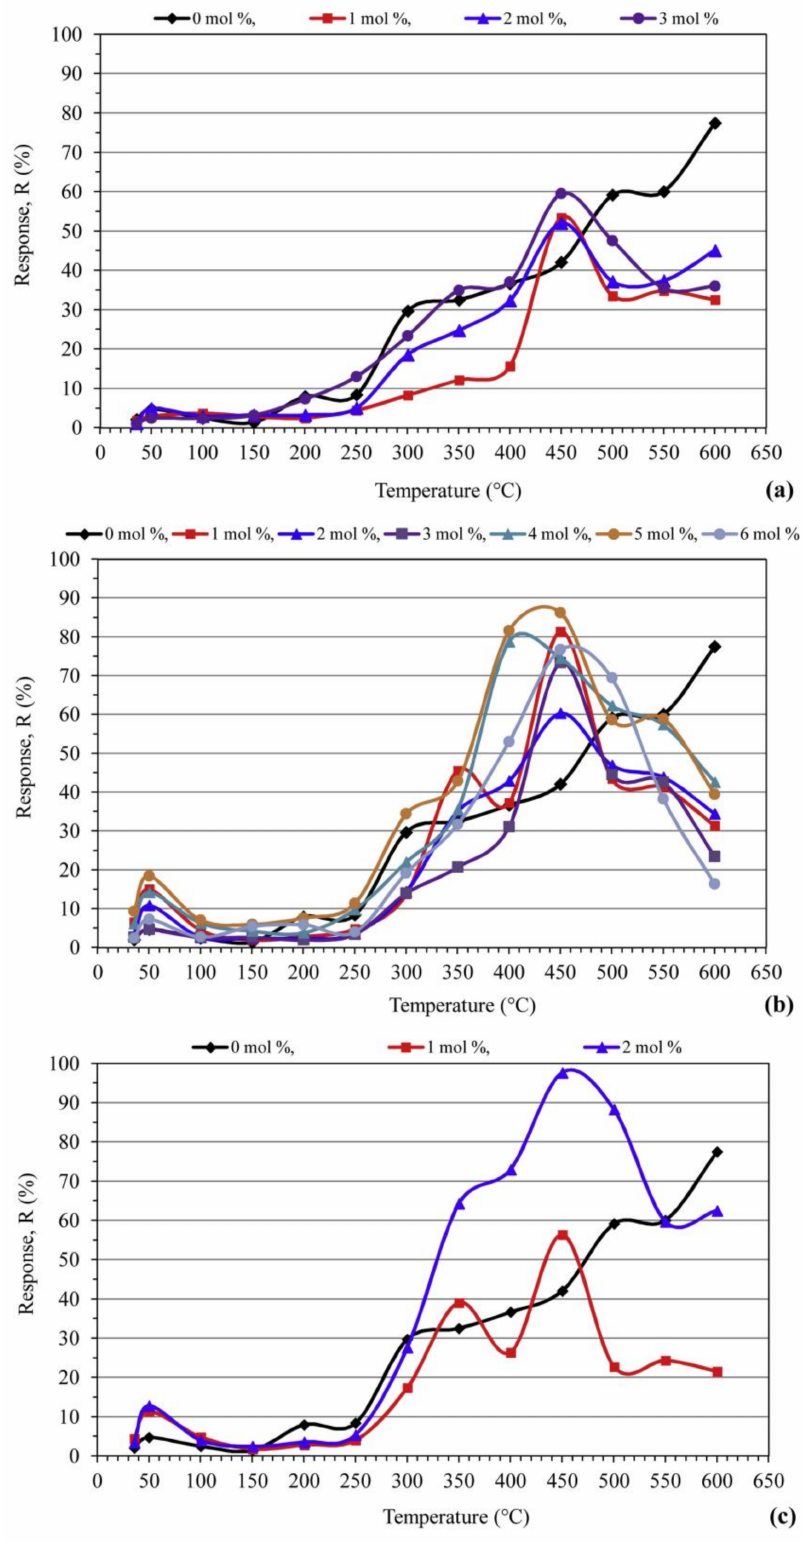
Figure 8. Variations of CO 2 sensor response with respect to temperature for ZnO nanorods based sensors: ( a ) Ge-doped; ( b ) Nd-doped; ( c ) W-doped. Reprinted with permission from reference [46]. From our experience on pure ZnO sensors for the detection of CO 2 , this sensing material is very sensitive not only to carbon dioxide but also to water vapor. On